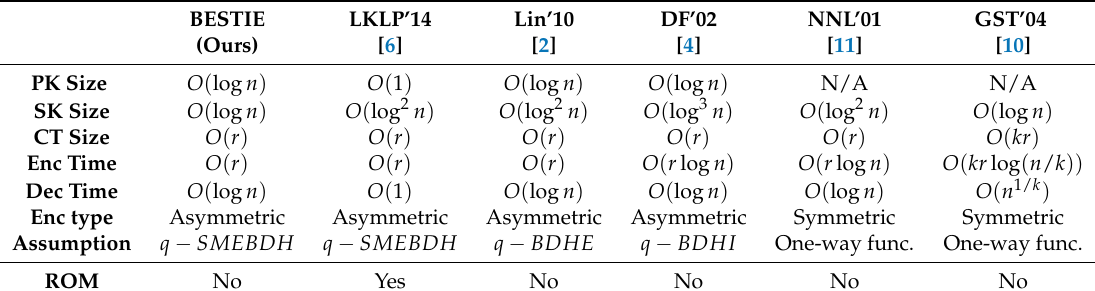
Table 1. Comparison of costs between SD-based public-key Broadcast encryption (BE). ref. n = the number of total users, and r = the number of revoked